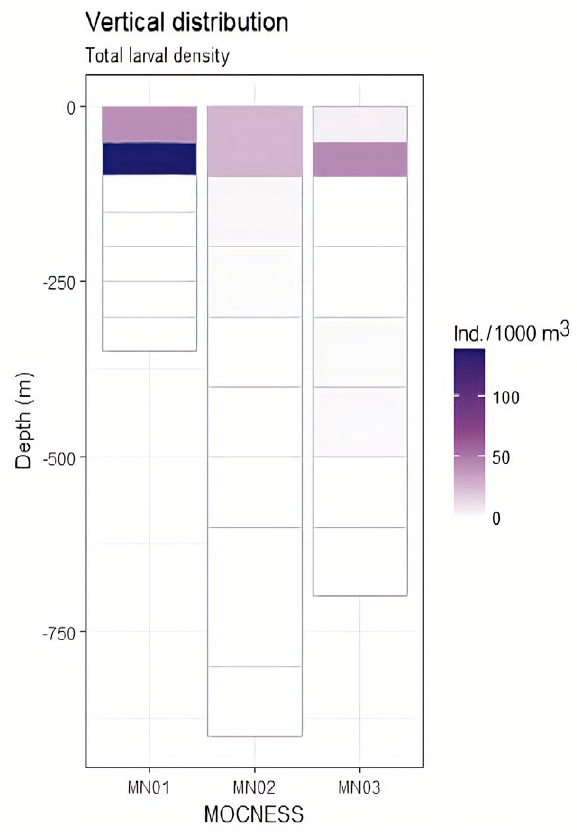
Fig. 7. – Abundance of decapod larvae at MOCNESS stations MN01, MN02 and MN03 in relation to sampling depth strata.